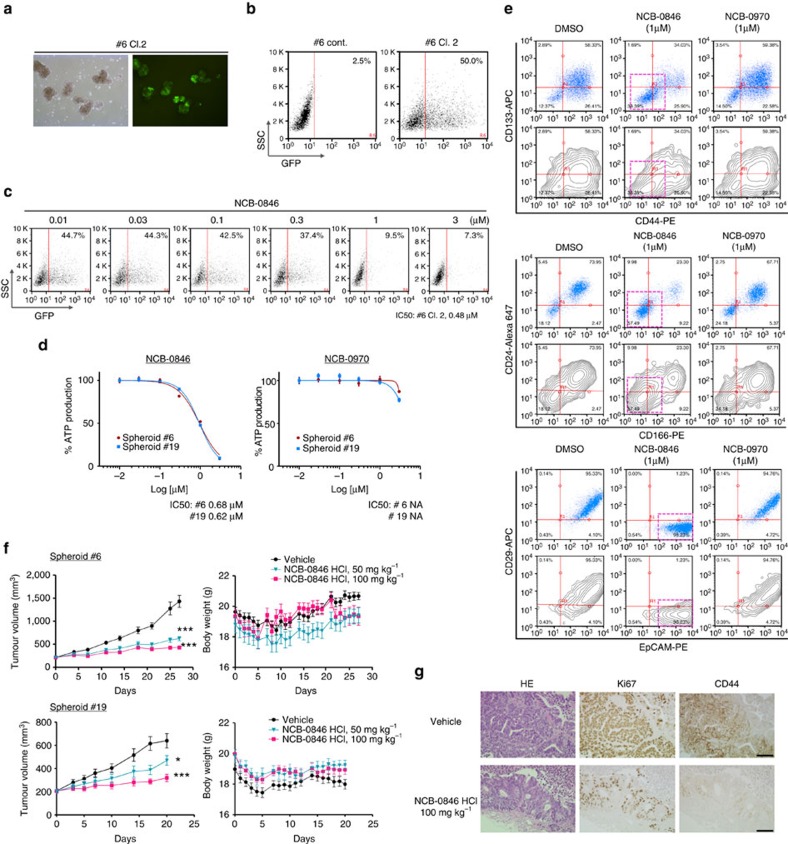
Patient-derived cancer-initiating cells.(a) Phase-contrast (left) and fluorescence (right) microscopy of a spheroid clone (named #6 Cl. 2) expressing Wnt-responsive promoter-driven green fluorescent protein (GFP). (b) GFP expression of a spheroid clone #6 Cl. 2 (right) and a control clone (#6 Cont.) (left) determined by flow cytometry. (c) Dose-dependent reduction of cells expressing Wnt-driven GFP in a spheroid clone #6 Cl. 2 by NCB-0846. (d) ATP production of spheroids #6 and #19 cultured for 3 days in the presence of the indicated concentration of NCB-0846 or NCB-0970. NA, not available (>3 μM). (e) Spheroid #6 was treated with DMSO (vehicle), NCB-0846 (1 μM), or NCB-0970 (1 μM) for 96 h. The population of cells expressing CD133, CD44, CD24, CD166, CD29 and EpCAM was determined by dual-color flow cytometry. APC, allophycocyanin; PE, phycoerythrin. (f) NOD/ShiJic-scid mice engrafted with patient-derived colon cancer spheroid #6 (1 × 104 cells) (top) or #19 (1 × 105 cells) (bottom) were orally administered NCB-0846 HCl (0, 50, or 100 mg kg−1, BID). *P<0.05, ***P<0.001 (Dunnett's test). Error bars represent s.e.m. (g) Excised tumours from mice engrafted with spheroid #6 and treated as described in f were analysed immunohistochemically with anti-Ki67 and anit-CD44v9 antibodies. Scale bar, 100 μm.